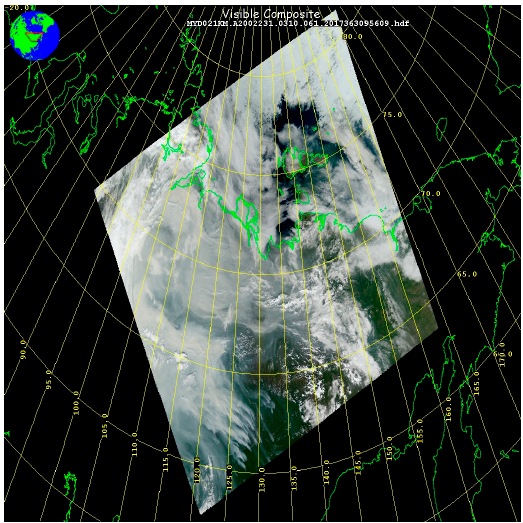
Figure 3. The MODIS/Aqua true color image at 0331 UTC on 19 August 2002 (downloaded from https://ladsweb.modaps.eosdis.nasa.gov/).